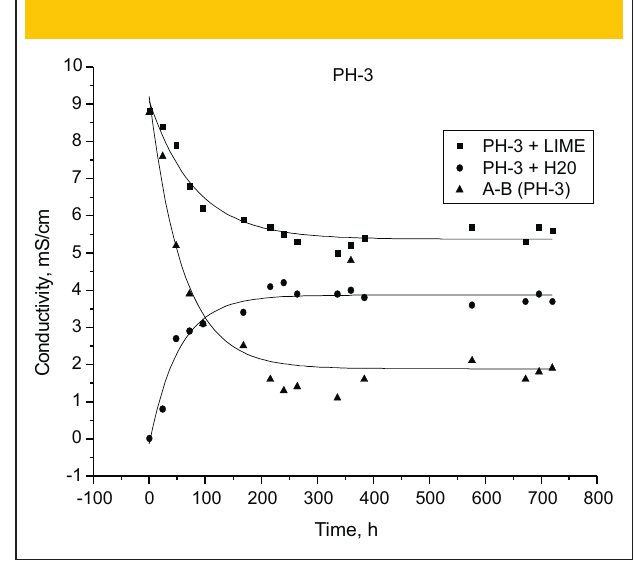
Figure 8 – Conductivity of ashes, graphics (A-B)